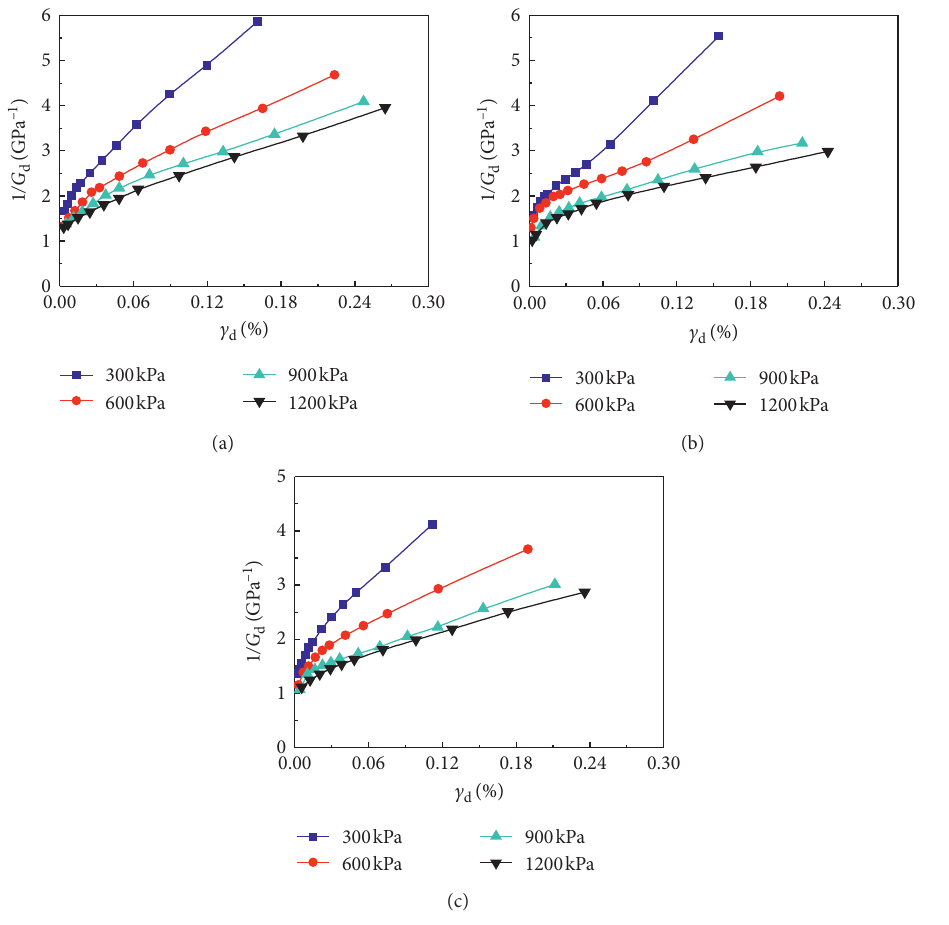
Figure 6: Shear moduli G d of the LCSG material under different cementing agent contents and according to changes in dynamic shear strain. (a) 40 kg/m 3 . (b) 60kg/m 3 . (c) 80 kg/m 3